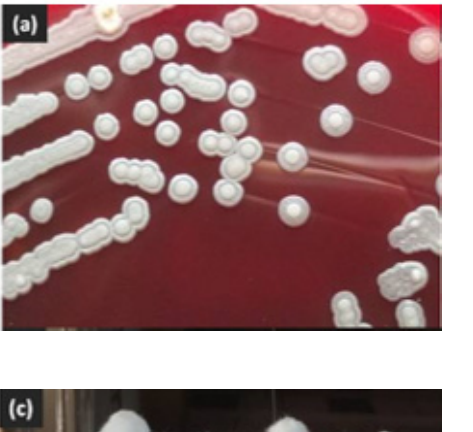
Figure 1. Contrast-enhanced CT neck showing left cervical abscess.